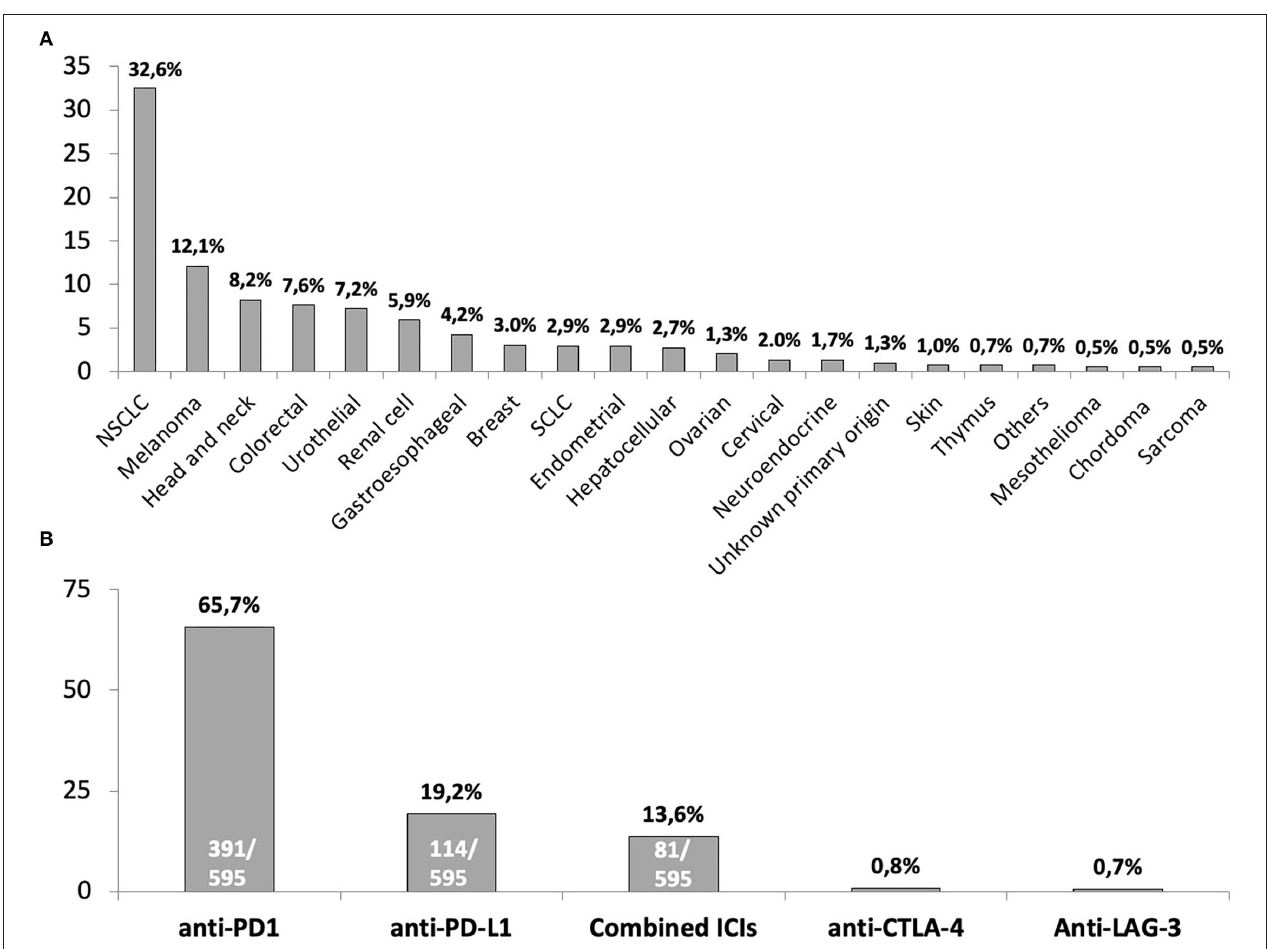
FIGURE 1 | Summary of underlying cancers for immune checkpoint inhibitors therapy (A) and immune checkpoint inhibitors scheme prescribed to included patients (B) . NSCLC, non-small cell lung cancer; SCLC, small cell lung cancer. The four (0.7%) subjects included in the “ Others ” tumors category comprised: 1 paraganglioma, 1 solitary fibrous tumor, 1 thyroid, 1 Hodgkin Lymphoma. In the case of monotherapy with anti-CTLA-4 or anti-LAG-3, the absolute number of subjects who received these schemes of ICIs were 5 and 4,